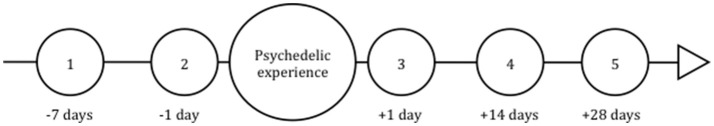
Study timeline. The numbers presented represent the five time points of measurement.